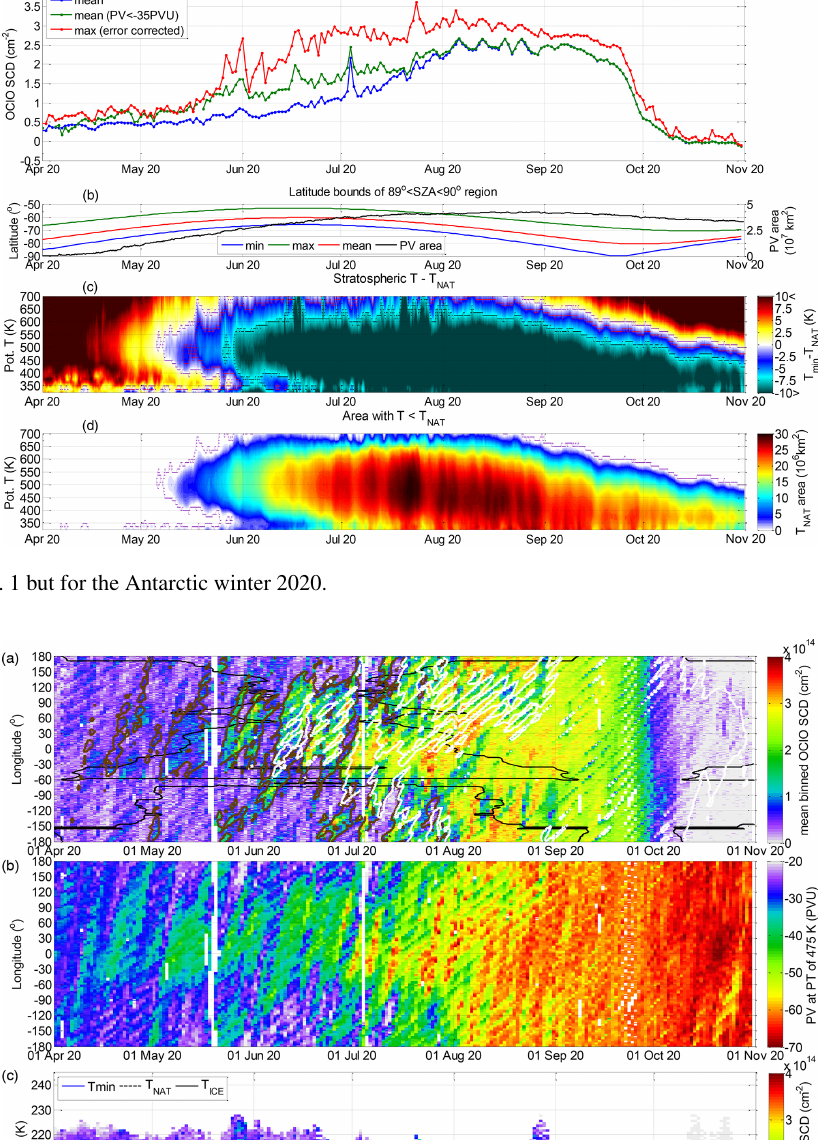
https://doi.org/10.5194/acp-22-245-2022 Atmos. Chem. Phys., 22, 245–272,